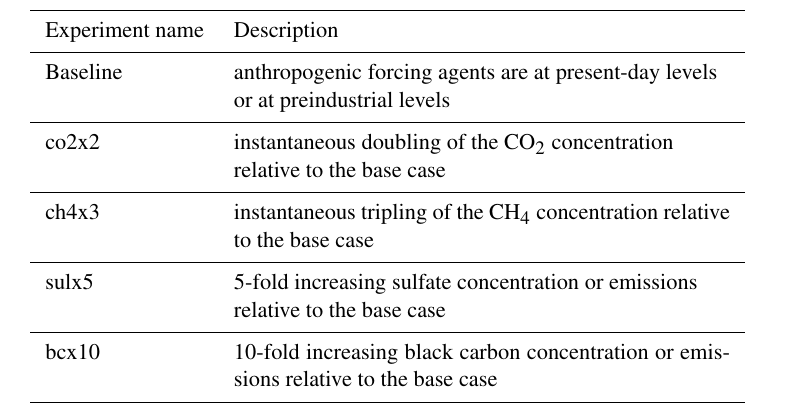
Table 2. Description of PDRMIP